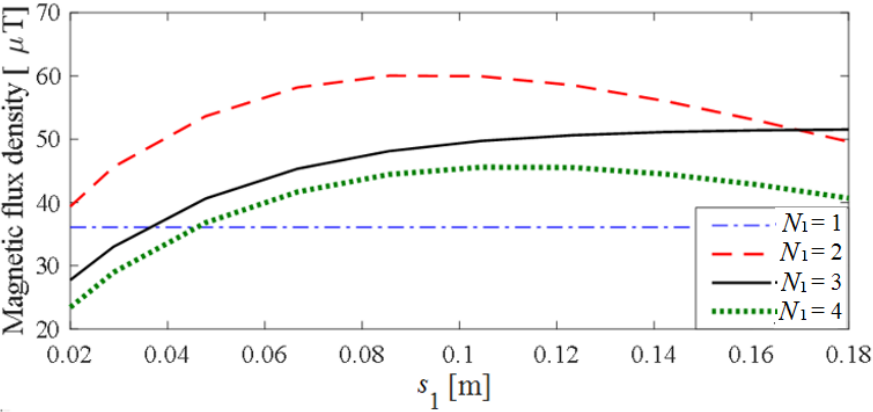
Figure 7. Magnetic-flux density B 1 at point p versus intraturn spacing s 1 , produced by maximum MMF 1 that, for each configuration, is compliant with SAR limit of 2 W/kg inside human torso.